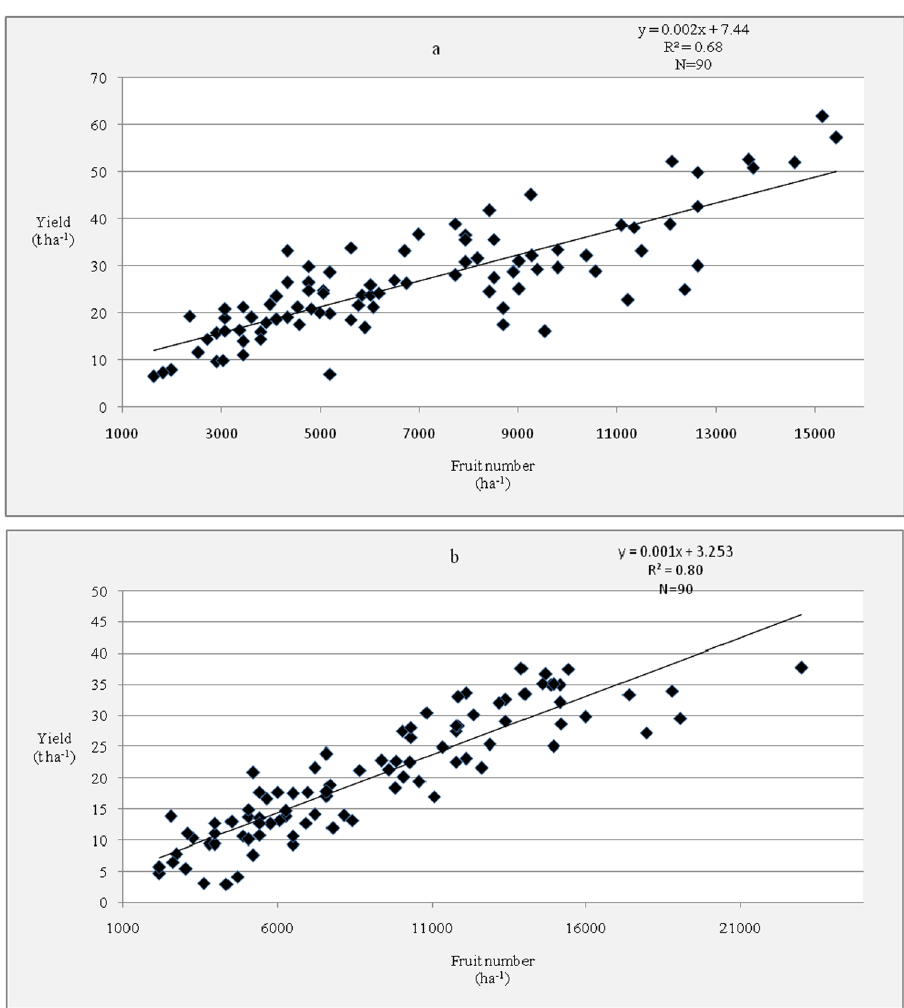
Figure 7: Linear regression of fruit yield on fruit number from ( a ) Crimson Sweet variety and ( b ) Sugar Baby